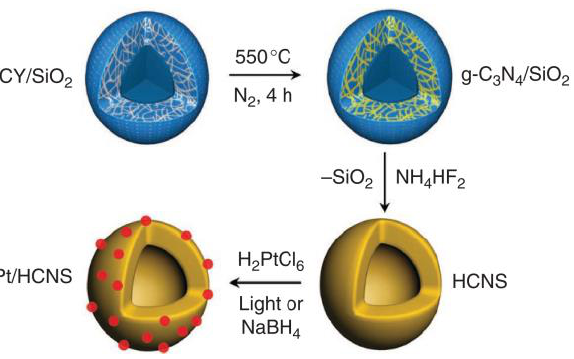
Figure 2. Illustration of HCNS and metal/HCNS composite syntheses. Reprinted with permission from Ref. [34]. Copyright 2012 Nature Publishing Group.